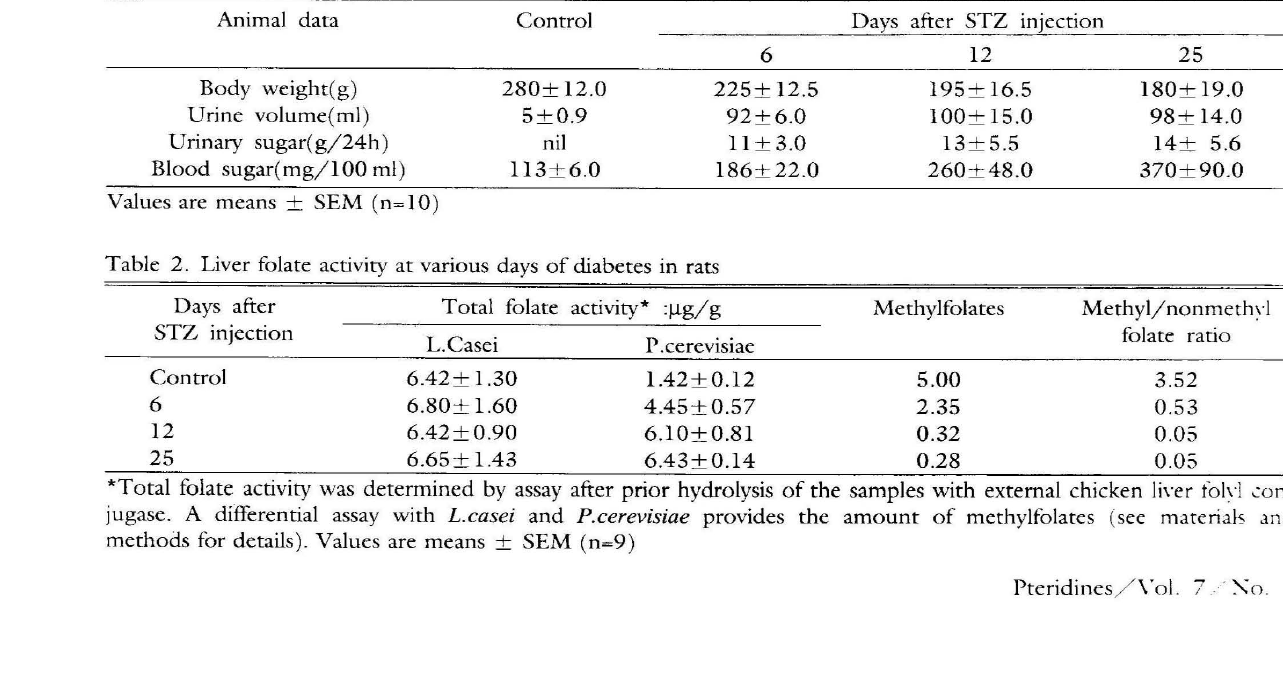
Table 2. Liver folate activity at various days of diabetes in rats Days after Total folate activity* :/J.g/